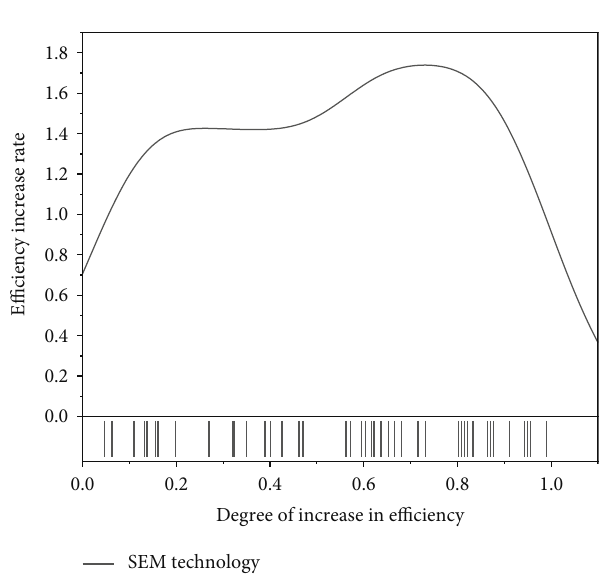
Figure 4: E ffi ciency di ff erences between SEM techniques and traditional analysis